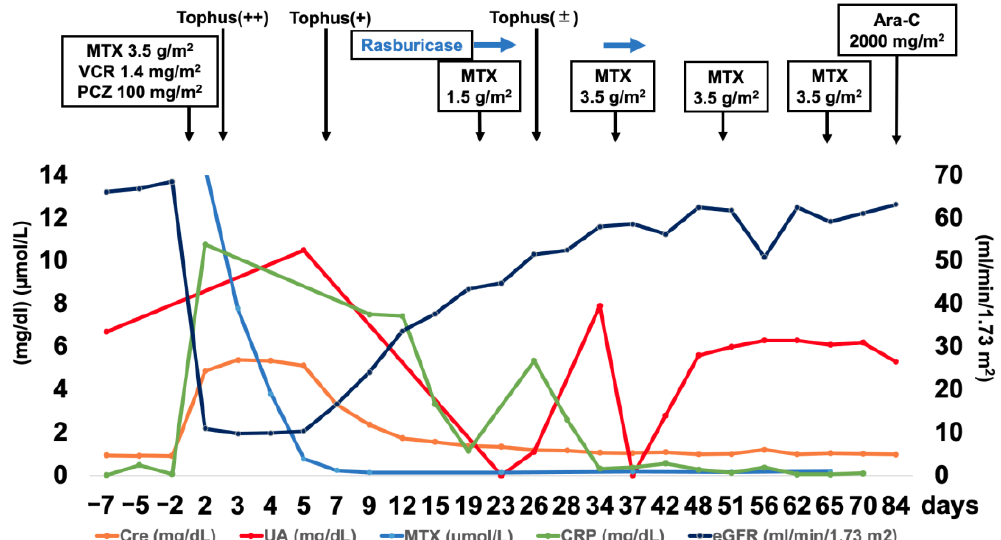
Figure 4. Timeline of the treatment, symptoms, and blood test results showing an elevation of uric acid and CRP (possibly reflecting the activeness of gout attack) and acute renal failure after the first administration of MTX. Bouts of tophus and uric acid elevation were subsequently controlled with rasburicase, and induction chemotherapy was ultimately completed. Abbreviations: Ara-C, cytara- bine; Cre, creatine; CRP, C-reactive protein; eGFR, estimated glomerular filtration rate; MTX, meth- otrexate; PCZ, procarbazine; UA, uric acid; VCR, vincristine.